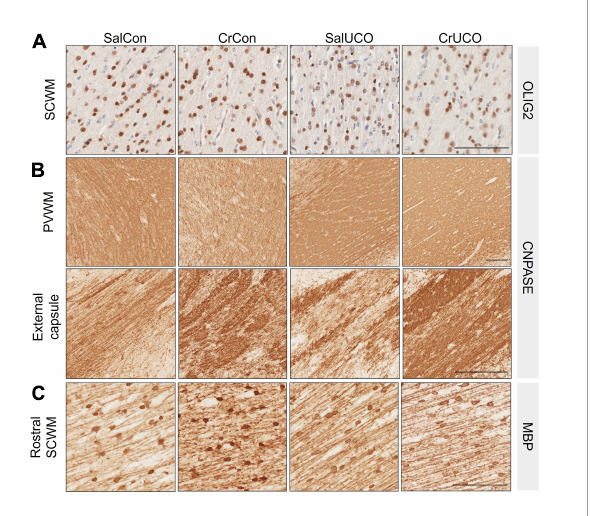
FIGURE4 (A) Representative images of Olig2-positive oligodendrocytes in the subcortical white matter (SCWM). (B) Representative images of CNPase-positive staining in the periventricular white matter (PVWM) and external capsule. (C) Representative images of MBP-positive oligodendrocytes and fibers indicating mature myelination in the rostral SCWM. Scale bar represents 100 µ